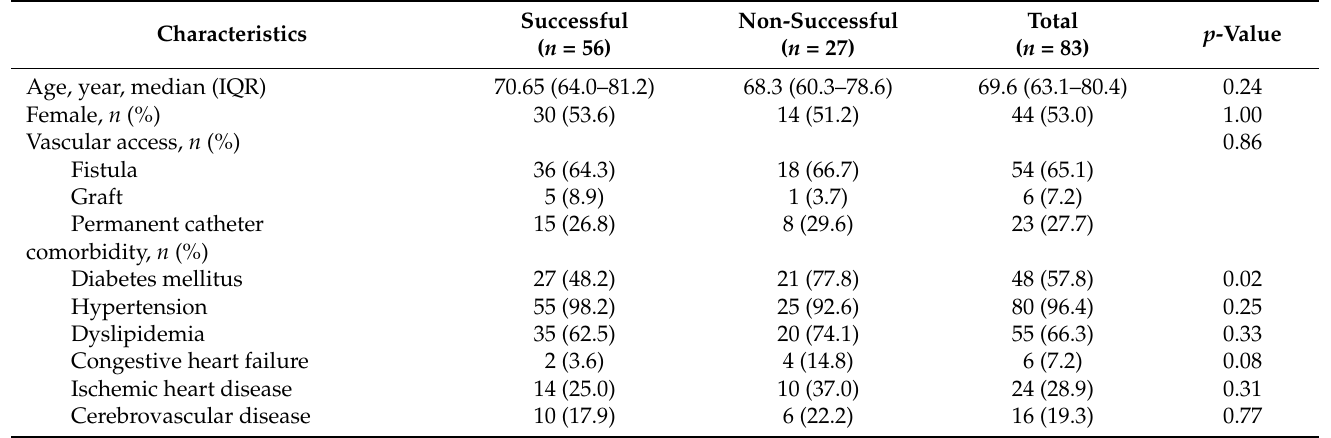
Table 1. Baseline characteristics of the hemodialysis